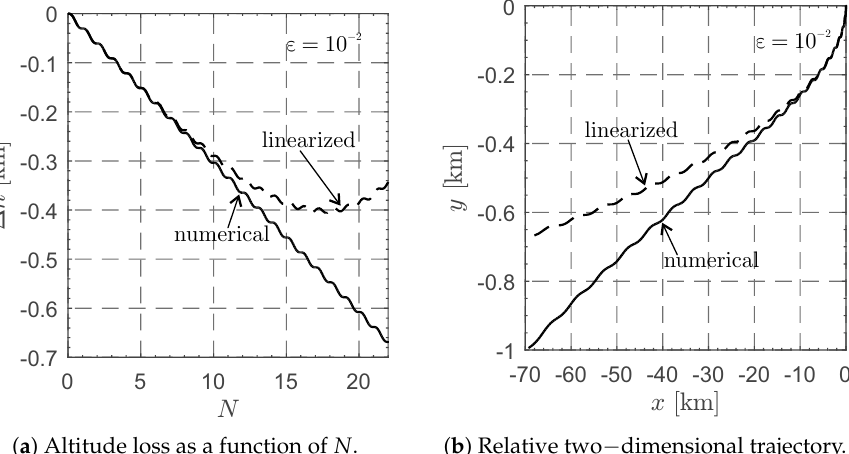
( b ) Relative two − dimensional trajectory. Figure 5. Comparison between the numerical (solid line) and linearized (dashed line) solutions when a T 0 = 0.0024mm/s 2 , h 0 = 1000km, and (cid:101) = 10 − 2 .